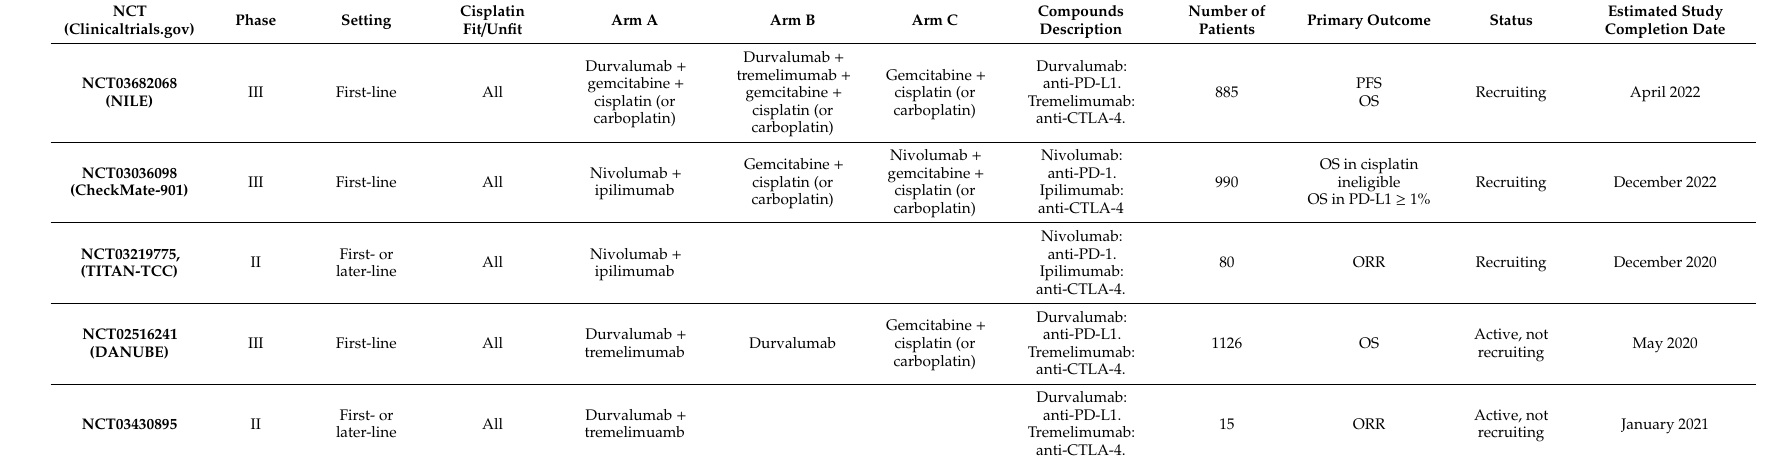
Table 2. Ongoing phase II / III trials of immune checkpoint inhibitor combined with other immune checkpoint inhibitors. ORR: overall response rate. PFS: progression-free survival. OS: overall